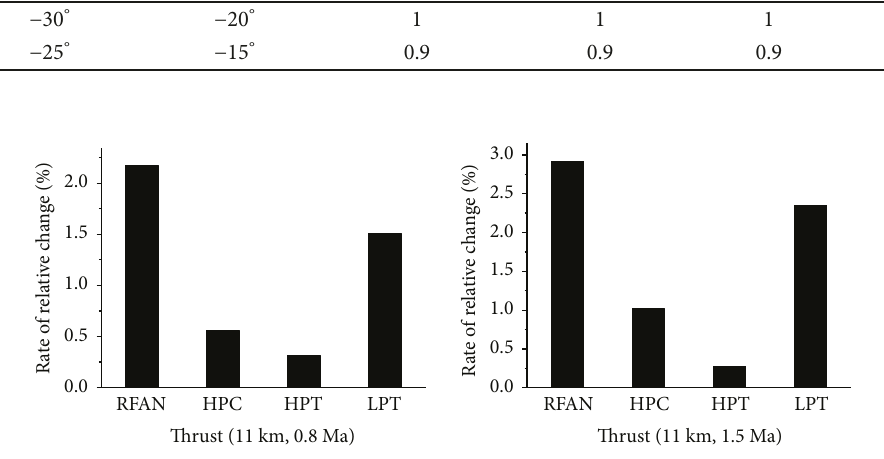
Figure 6: Sensitivity analysis of variable geometries on thrust (part 1).